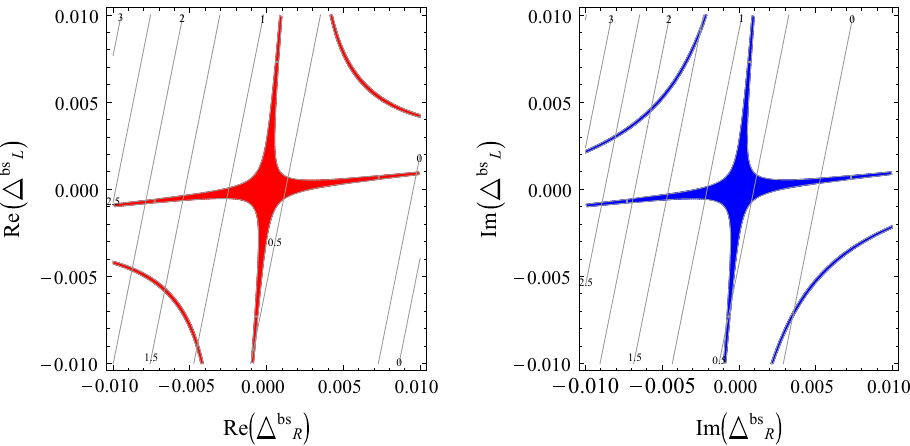
π 0 η (cid:3) in the LRS for the case Im ((cid:5) sb 2